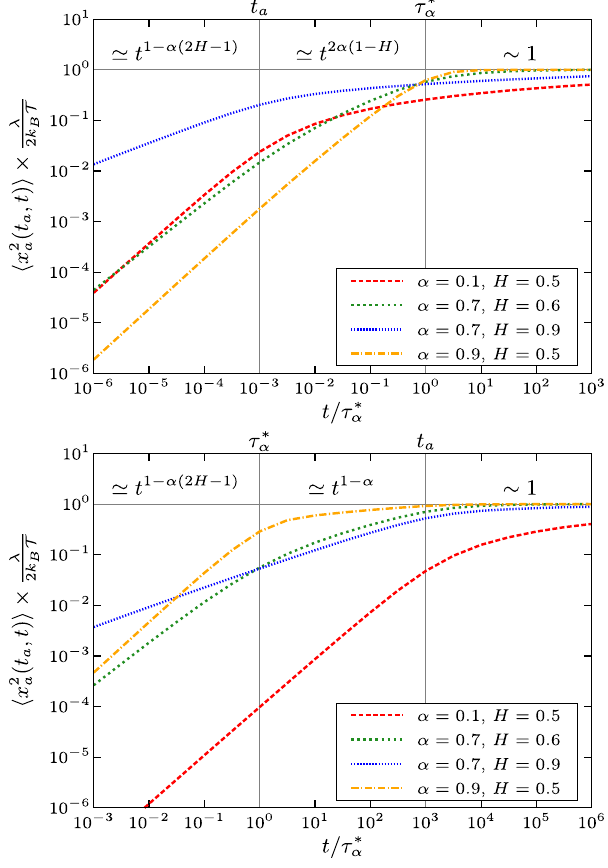
FIG. 6 (color online). Time evolution of the ensemble-averaged mean-squared displacement for combined CTRW and over- damped, confined FLE dynamics. Plots are numerical evaluations of the convolution integral (54). We study several parameter configurations for H and α . The behavior is characterized by a double turnover between several power-law regimes as labeled above the graphs; see also Eq. (55). Respective turnover time scales τ (cid:2) α and t are indicated as vertical lines. A horizontal line a → 2 k T = λ . Top: The gives the infinite time stationary limit h x 2 b a i ensemble measurement starts at a time where internal FLE ≪ τ (cid:2) dynamics have not yet relaxed to equilibrium; i.e., t α . a ≫ τ (cid:2) Bottom: Opposite case, t α a